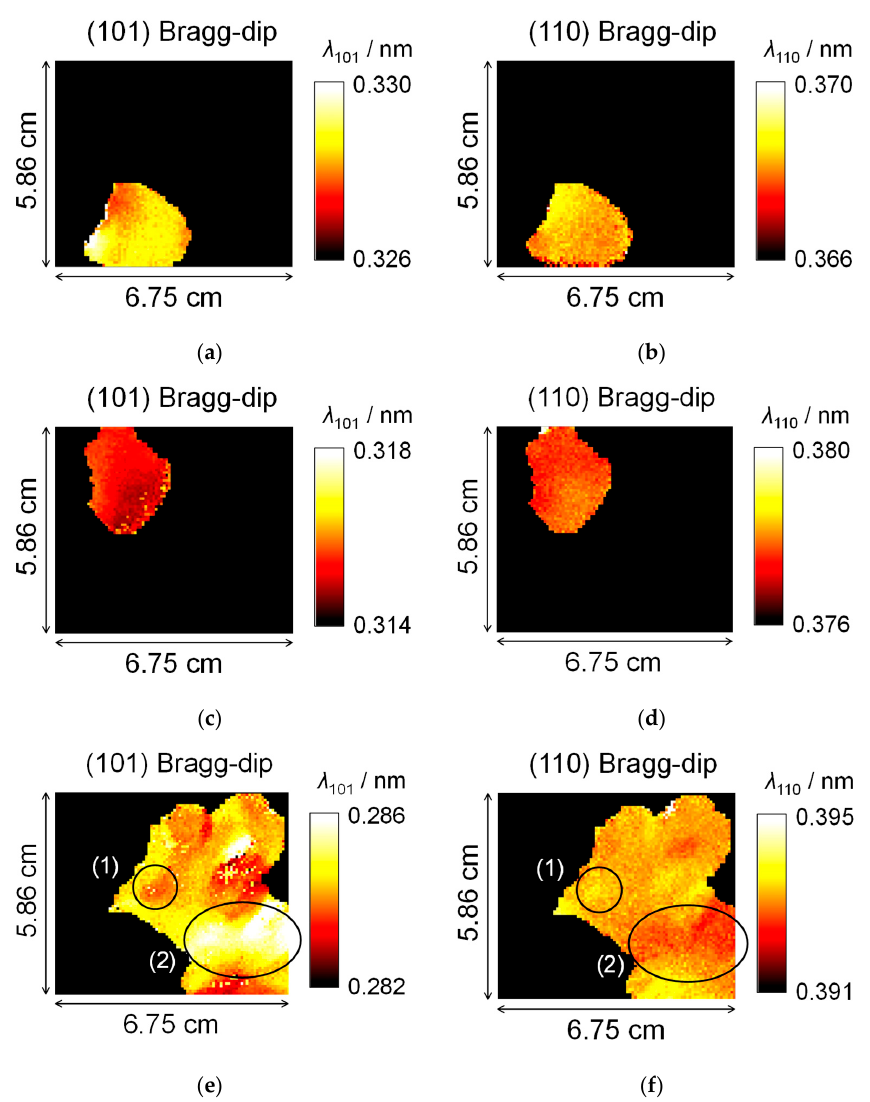
Figure 5. ( a ) Imaging of (101) Bragg-dip wavelength of Grain 1. ( b ) Imaging of (110) Bragg-dip wavelength of Grain 1. ( c ) Imaging of (101) Bragg-dip wavelength of Grain 2. ( d ) Imaging of (110) Bragg-dip wavelength of Grain 2. ( e ) Imaging of (101) Bragg-dip wavelength of Grain 3. ( f ) Imaging of (110) Bragg-dip wavelength of Grain 3.